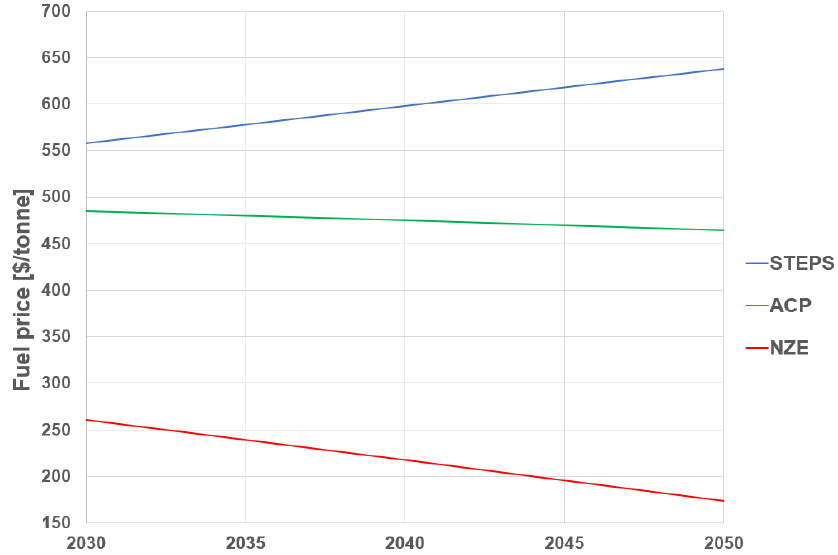
9 of 22 Figure 4. Carbon pricing scenarios. Emission costs are calculated by the following equation [13]: